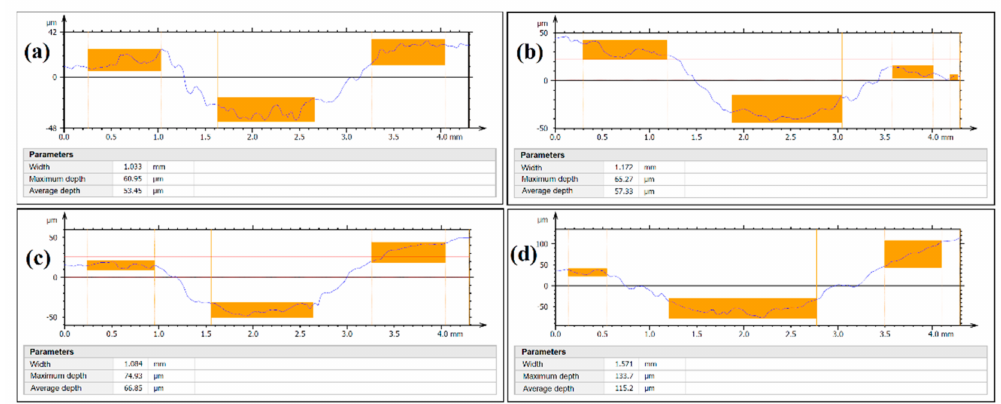
Figure 14. Surface roughness profiles after wear resistance tests for ( a ) diffusion borochromized layer, ( b ) B-Cr coatings produced using 600 W, ( c ) B-Cr coatings produced using 900 W, and ( d ) B-Cr coatings produced using 1200